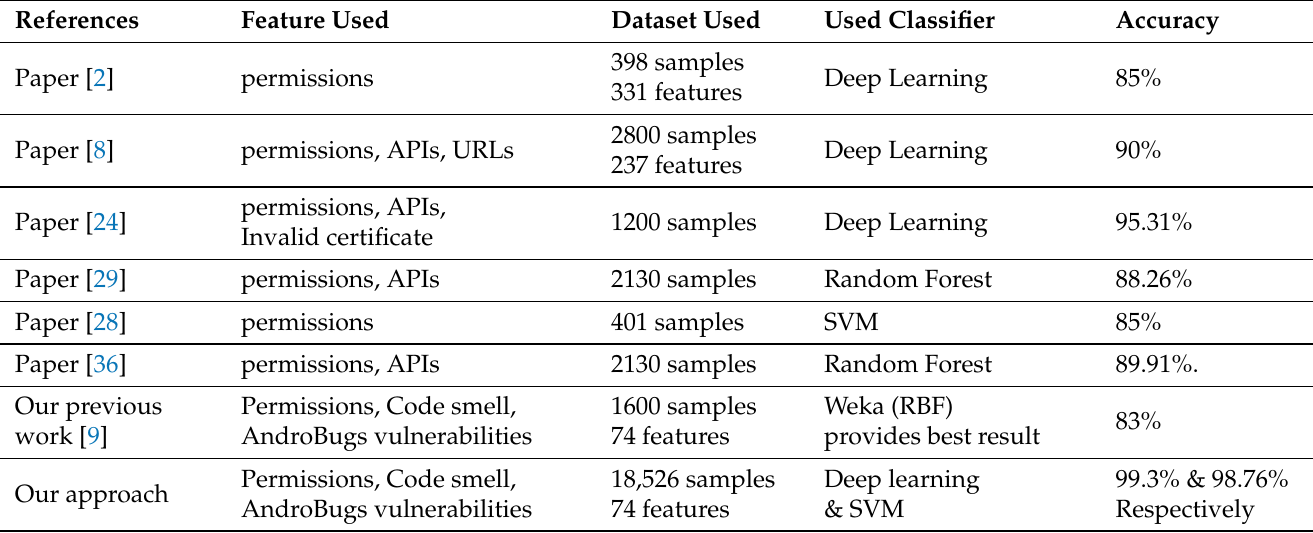
Table 9. Comparison between state of the art research and our